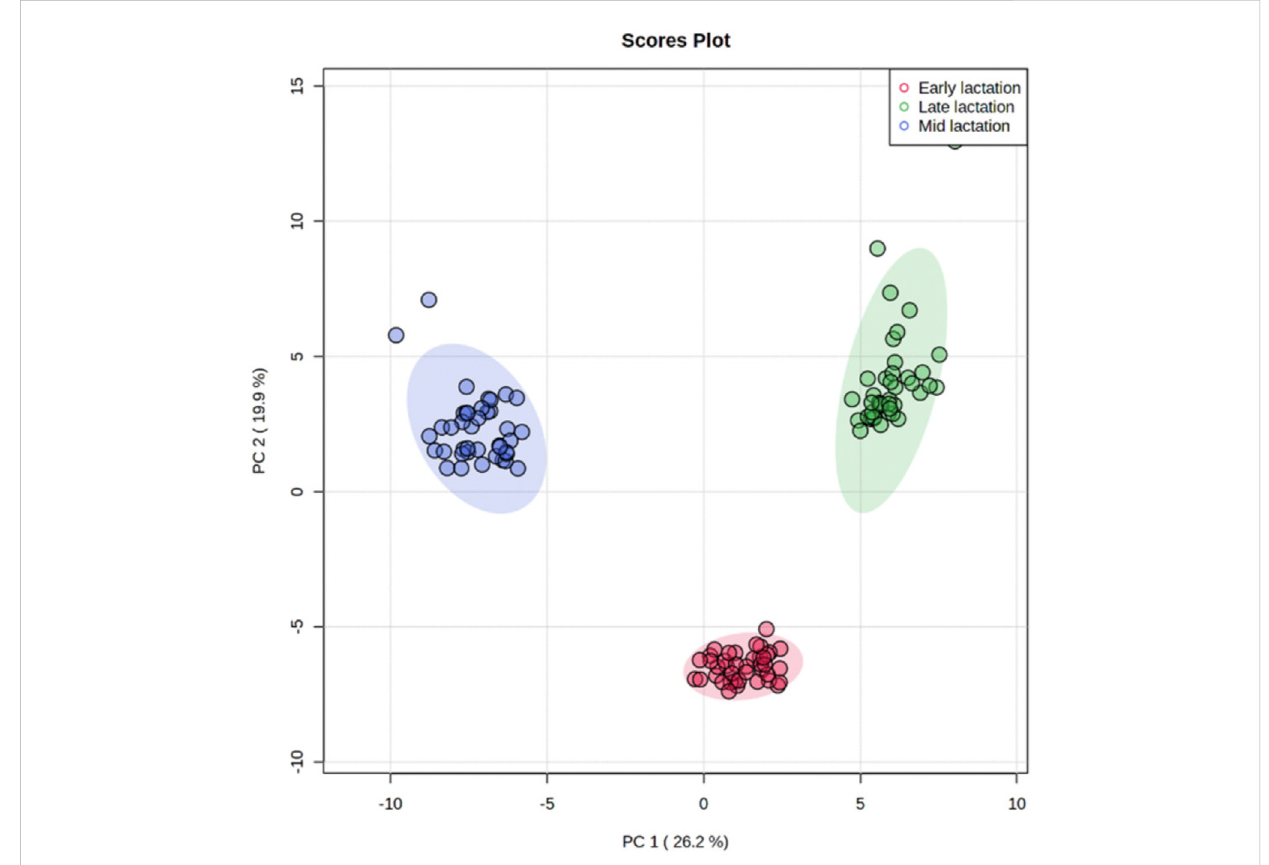
FIGURE 2 Principal component analysis showing a clear separation in the milk metabolite pro fi les of cows among early, mid and late lactation